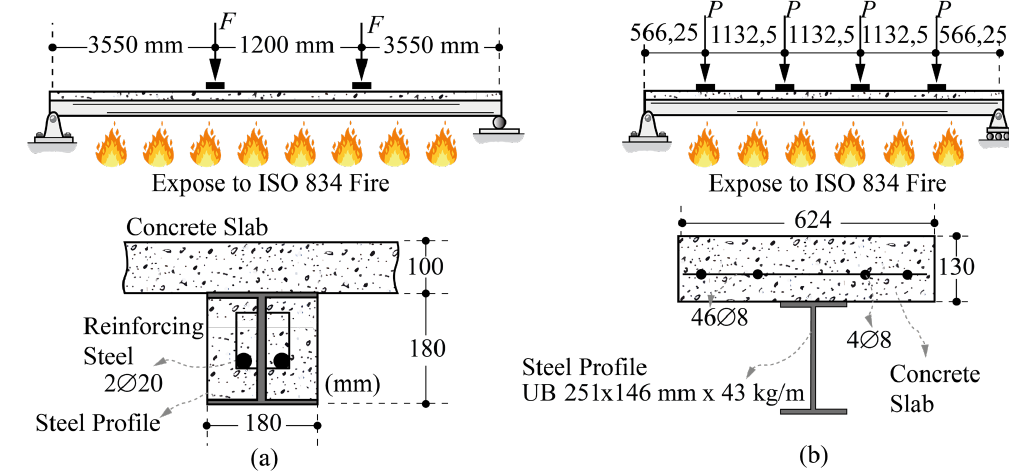
Figure 10. Characteristics and dimensions of the cross-section of the composite steel-concrete beam model with (a) section partially encased with slab and (b) H-section with